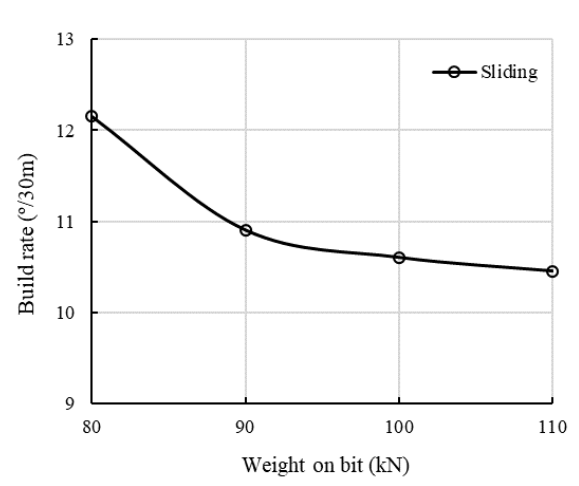
Fig. 10. Sliding build rate VS inclination for BH-PDM-S BHA Fig. 12. Sliding build rate VS WOB for BH-PDM-S BHA